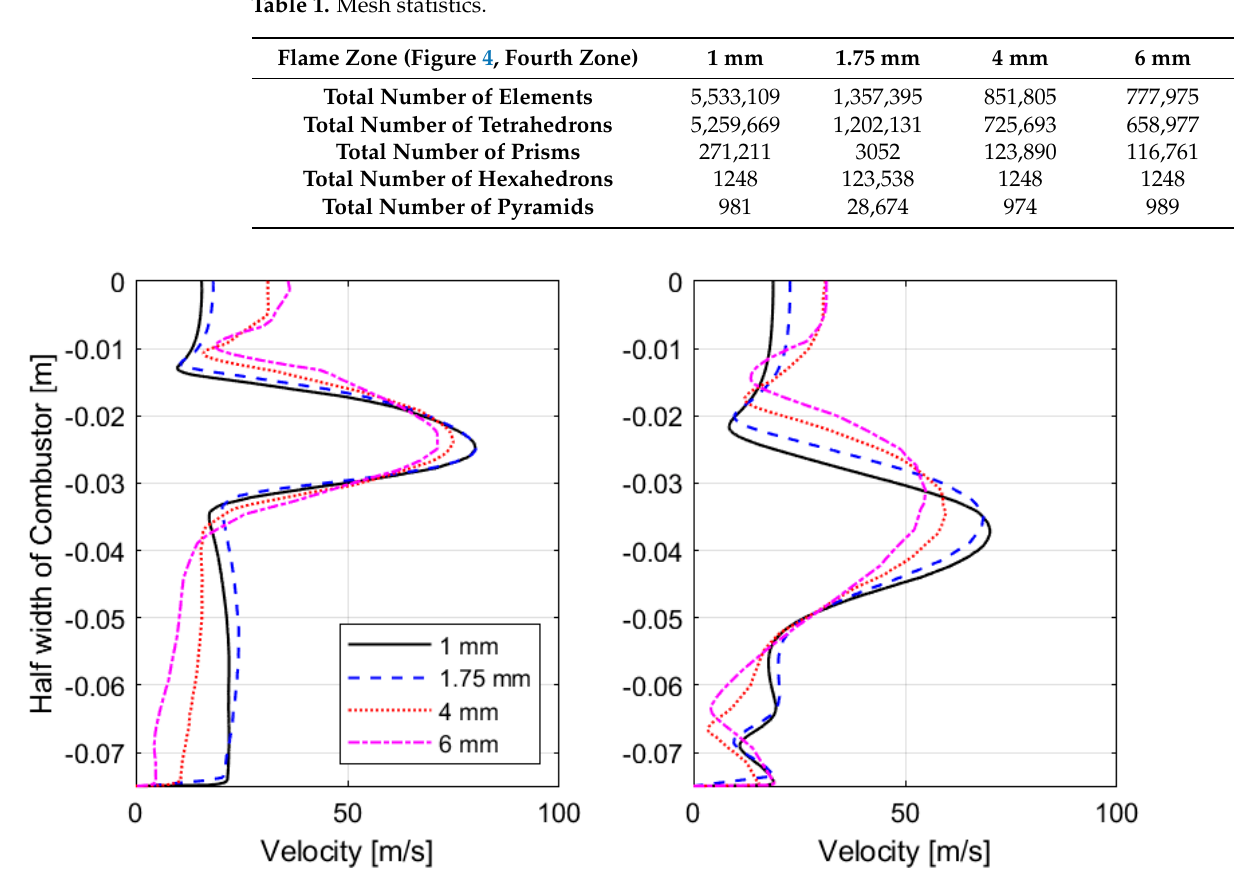
Figure 5. Mesh dependency study for different grid sizes based on the streamwise (single component of) velocity.